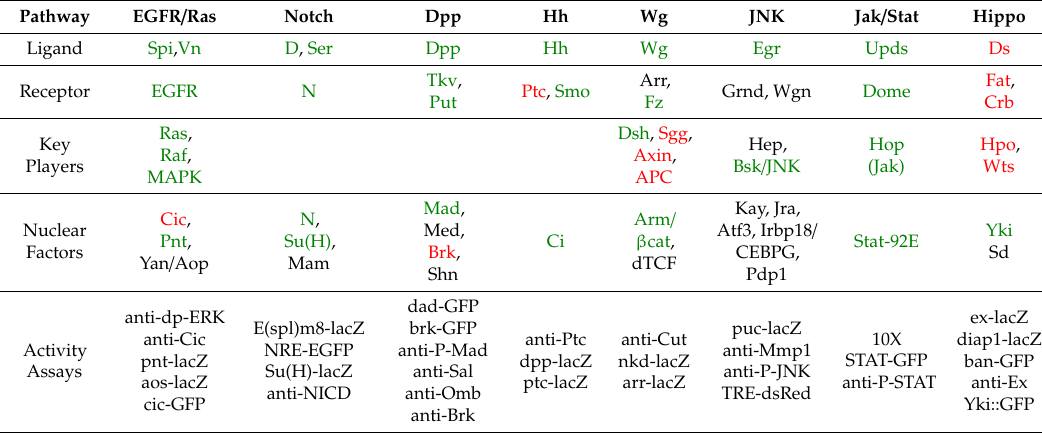
Table 1. Common pathway members and their activity read-outs. A brief introduction of the key players of the pathways that were examined in this work. EGFR, Epidermal Growth Factor Receptor; Dpp, Decapentaplegic; Hh, Hedgehog; Wg, Wingless; JNK, Jun N-terminal Kinase; Jak / Stat, Janus Kinase / Signal Transducer and Activator of Transcription; Spi, Spitz; Vn, Vein; MAPK,